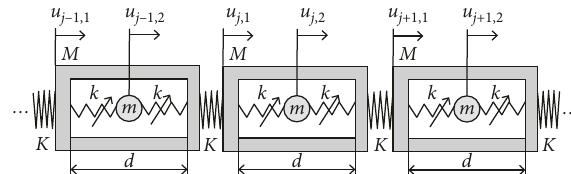
Figure 1: Metamaterial effective negative mass with the pure Duffing